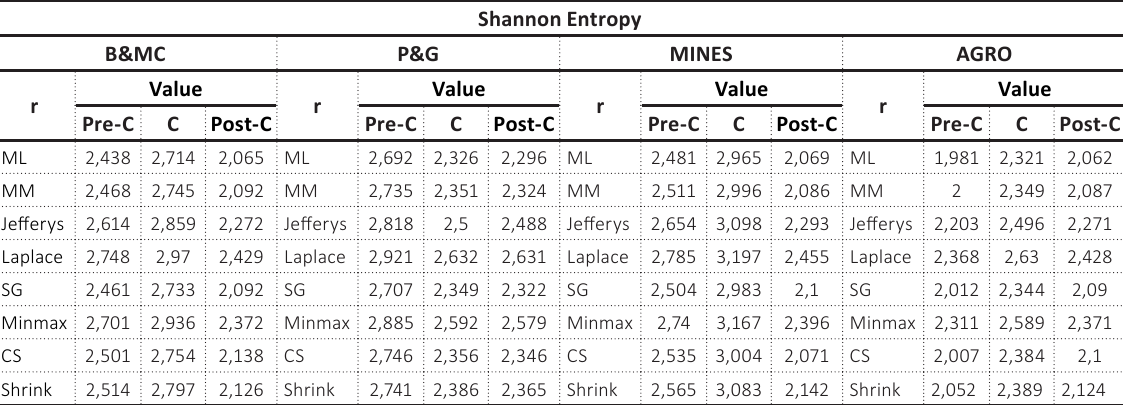
Table A2. Different Shannon entropy measures of B&MC, P&G, MINES, AGRO, DISTR, BOISS, and BANK before the COVID-19 crisis (Pre-c), during the COVID-19 crisis (C), and after the COVID-19 crisis